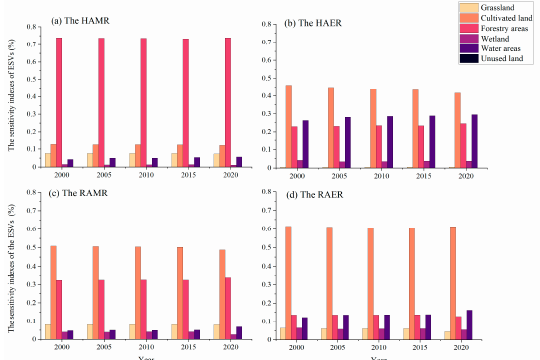
Figure 4. Sensitivity indexes in ecosystem service values of all land use types in the HAMR, HAER, RAMR, and RAER. ( a ) Sensitivity indexes of ecosystem service values in the HAMR, ( b ) Sensitivity indexes of ecosystem service values in the HAER, ( c ) Sensitivity indexes of ecosystem service values in the RAMR, ( d ) Sensitivity indexes of ecosystem service values in the RAER.